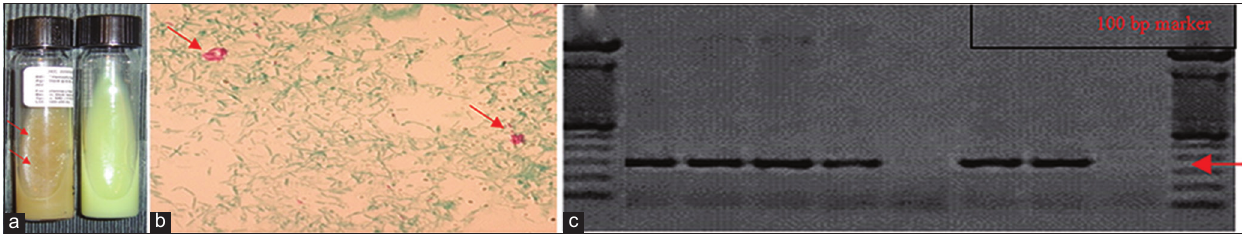
Figure-2: Diagnostic test results. (a) Culture: Small white to yellow half ball shape or pinhead Mycobacterium avium subspecies paratuberculosis colonies (left side tube), while no colonies were observed on the right side tube. (b) ZN stain: Detection of acid-fast bacilli after microscopic examination. (c) Polymerase chain reaction: Amplification products (357 bp) were visualized on an ultraviolet transilluminator after electrophoresis at 125 volts for 45 min in 1.5% agarose gels pre- stained with ethidium